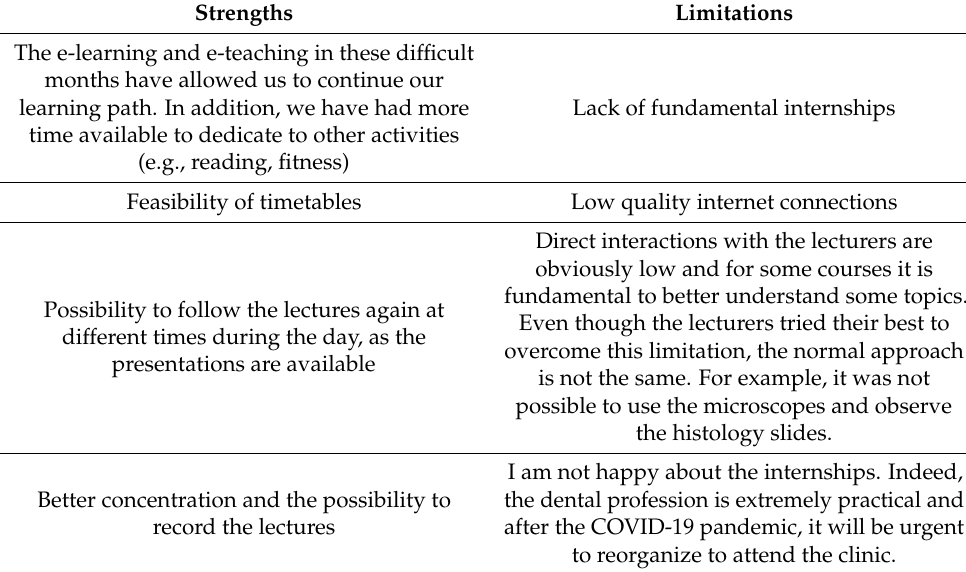
Table 3. Most representative points raised by the students in the open-ended questions. Quotations are translated from Italian, for present